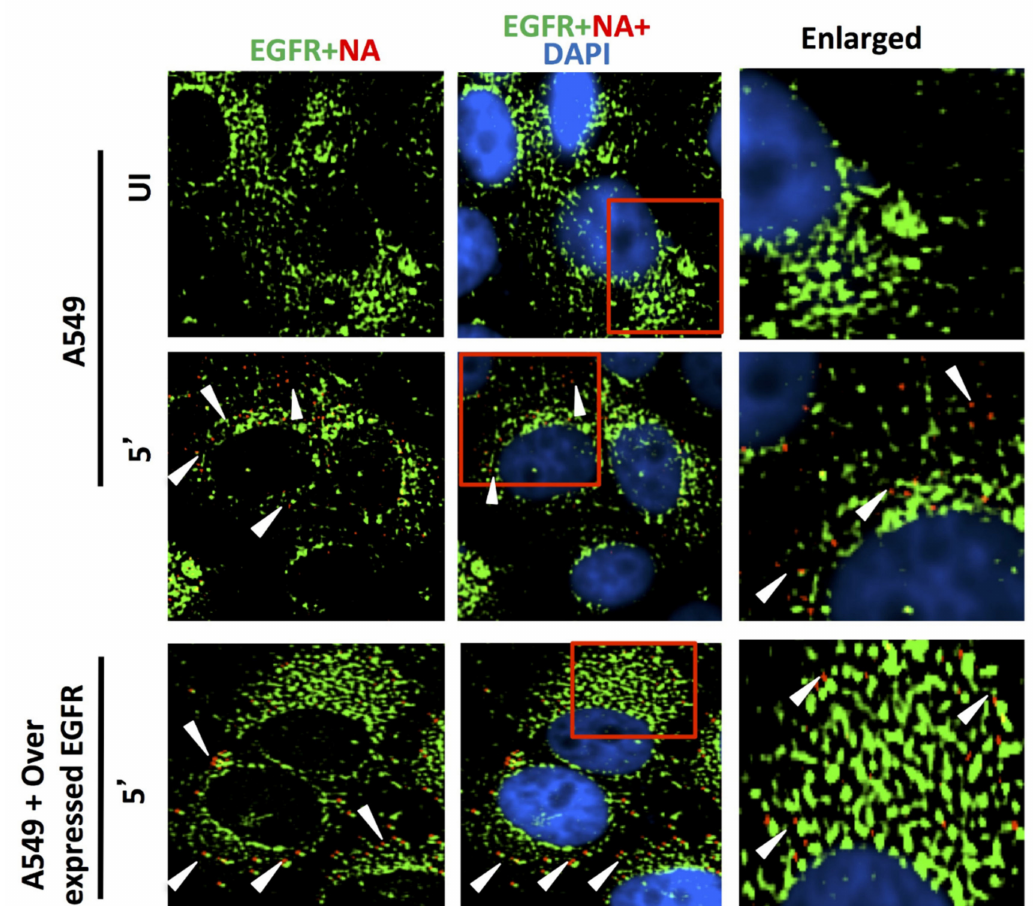
Figure 8. Comparing the ability of host membrane proteins CD66c, EGFR and DC-SIGN respectively in IAV binding on A549 cells through fluorescent microscopy. UI denotes uninfected cells; 5 (cid:48) , Cells after 5 min of virus binding. A549 cells were cultured either with endogenous level of expression or overexpression of receptor candidates EGFR, CD66c or DC-SIGN. Cells were either uninfected or infected with 5 MOI of A/PR8/34 influenza virus for 5 min. The secondary antibody Alexa 488 (green) probed host EGFR and Alexa 594 (red) probed influenza NA; cell nuclei are stained with DAPI (blue). No trace of virus binding in uninfected cells (top panel); modest virus binding on cell surface is observed after 5 min of incubation influenza NA (red). Only few virus particles are colocalizing with EGFR (middle panel, yellow spots, white arrow). In EGFR overexpressing A549 cells there is neither corresponding increase in virus binding nor in colocalization of viral NA with EGFR. Rather cells overexpressing EGFR show similar virus binding pattern as cells with endogenous level of EGFR (bottom panel). Altogether, virus binding is not significantly increased with overexpression of EGFR, suggesting its poor binding